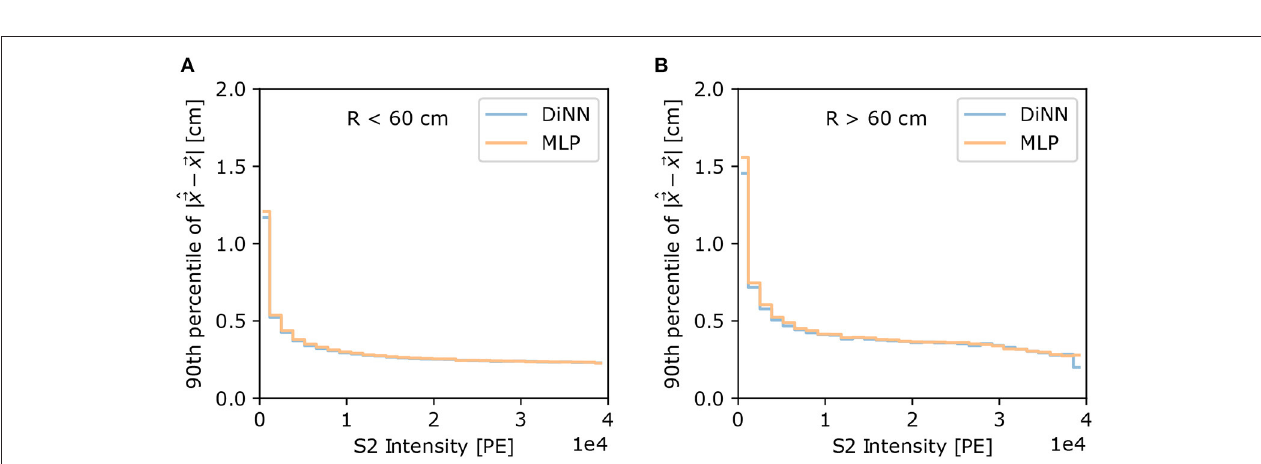
FIGURE 8 | The 90th percentile of localization error as a function of S2 intensity, for (A) R < 60 cm and (B) R > 60 cm. S2s with higher intensities are localized with smaller error by both models, and S2s at R > 60 cm region are localized with larger error than S2s at R < 60 cm region, both as expected.